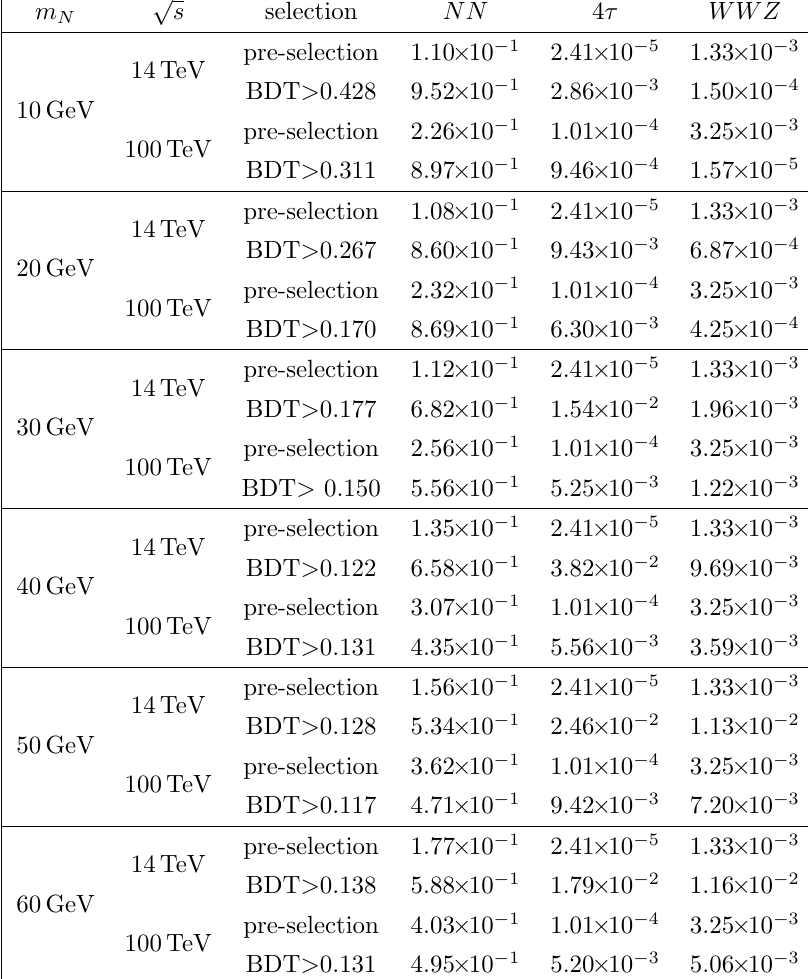
Table 2 . Selection e(cid:14)ciencies for the signal NN and background processes of 4 (cid:28) and WWZ at the HL-LHC (with center-of-mass energy p s = 14 TeV) and FCC-hh/SppC (with p s = 100 TeV) for m N = 10, 20, 30, 40, 50, 60 GeV, respectively. Here h 2 is assumed to be heavy and only h 1 decay contributes to the signal NN .